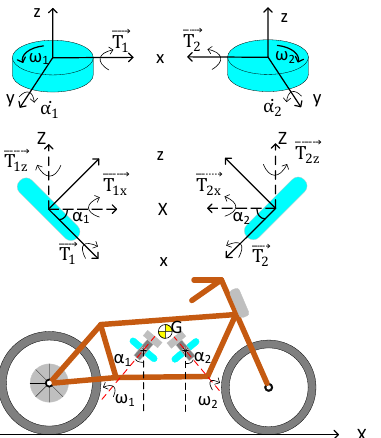
Figure 2. Structure of the two-wheeled motorcycle equipped with SGCMG.